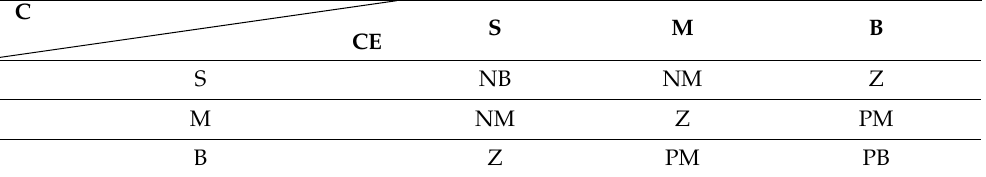
Table 2. Rule Base for Type 2 fuzzy